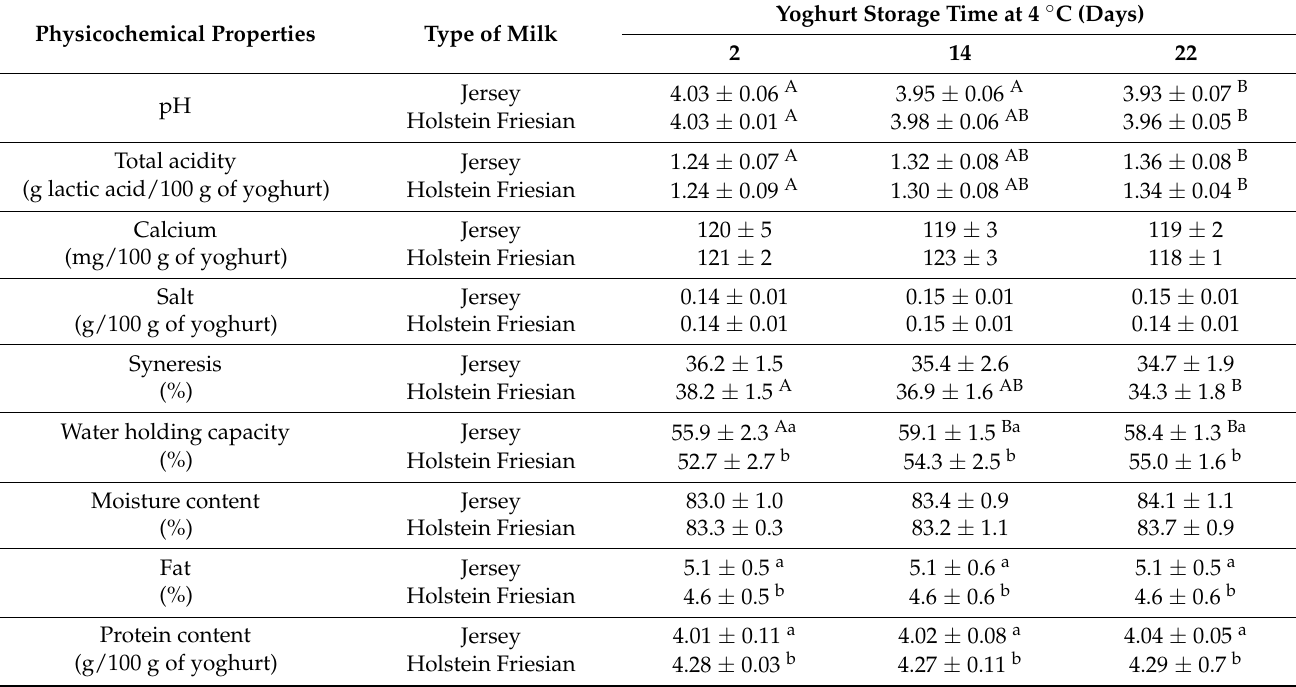
Table 3. Physicochemical properties of traditional-type Greek yoghurts during the safe consumption period of the product (22